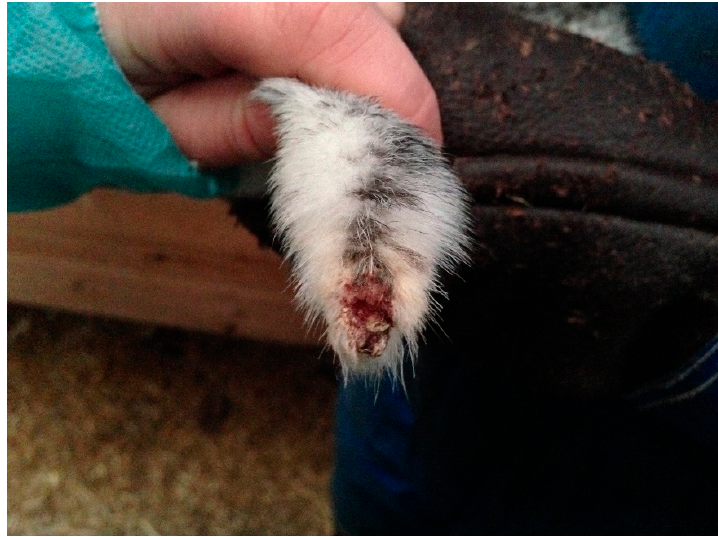
Figure 4. Typical morphology of a wound probably caused by tail hitting the wire mesh, located on the ventral side of the mink tail.